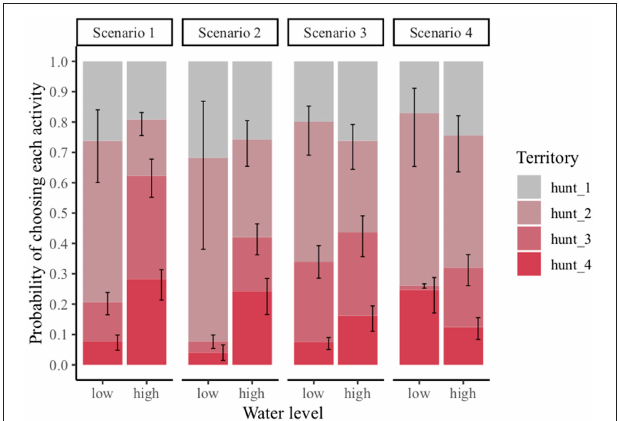
FIGURE 7 | Probability of choosing each hunting territory at every season and scenarios with money availability held constant at the sample mean. The confidence intervals are the 95th percentile intervals, as calculated from the posterior samples of the model. In gray is the reference level (hunting in territory 1).